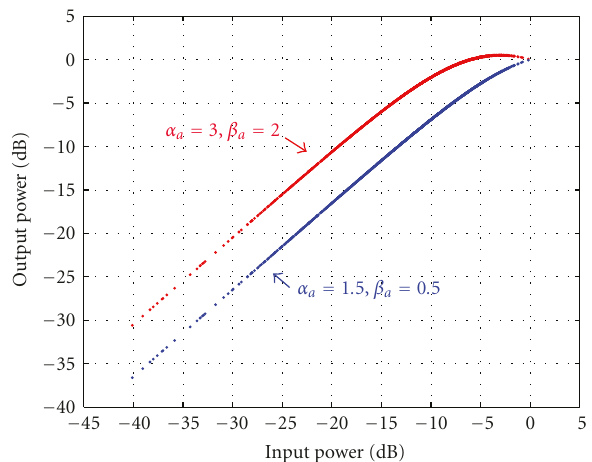
Figure 4: AM/AM characteristic variation. Figure 5: AM/PM characteristic variation.